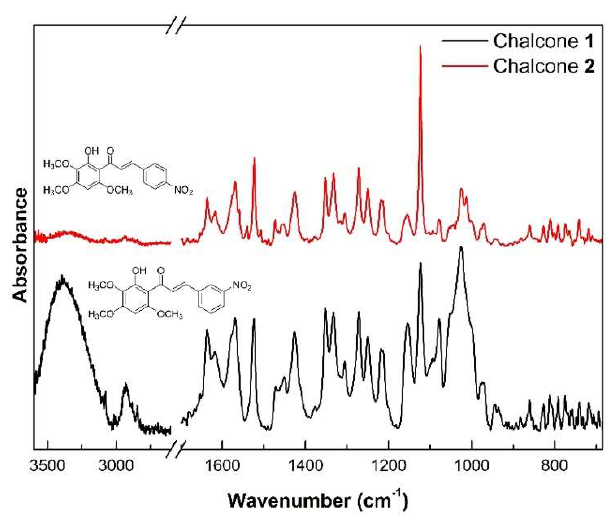
Figure 7. Experimental spectra of ATR-FTIR of the chalcones 1 and 2.